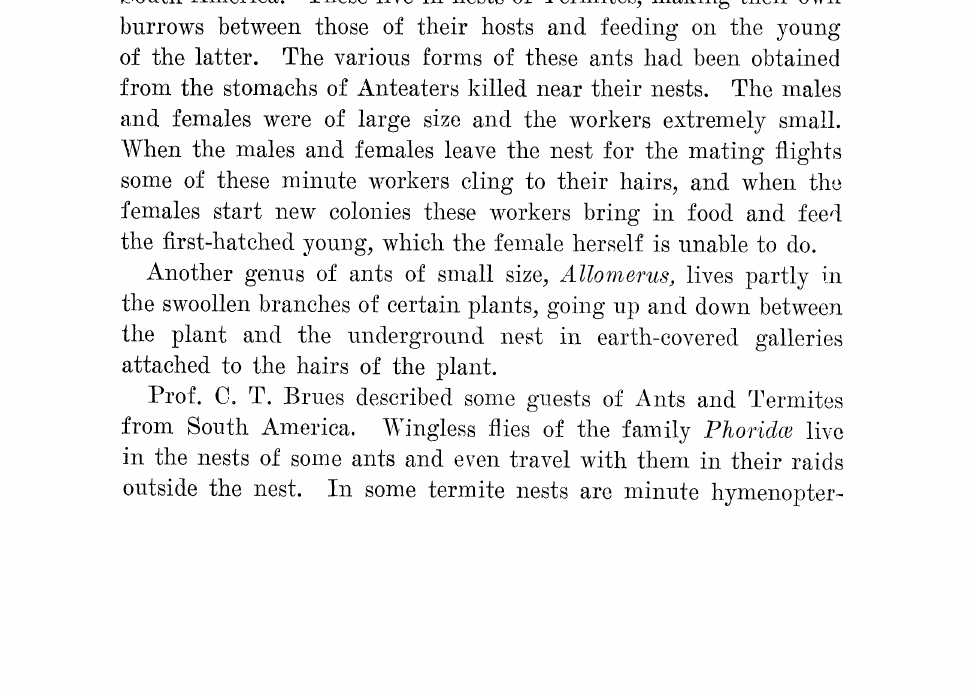
Fig. 5. Posterior (ventral) view o: the paragnaths of the crustacean Apseudes. Fig. 6. Posterior (ventral) view of a pa.ragnath and mxillula of the crus- tacean Squilla. Fig. 7. Anterior (dorsal) view of a paragnath and maxillula of the crus- tacean Apus, bent over backward to show attachment to the basal lamina. Fig. 8. Ventral (posterior) view of a paragnath and the lingua of the insect Machilis. Fig. 9. Same view o1 a paragna.th of Mchiis taken from drawing by Carpenter. Fig. 10. Anterior view of metastoma of the trilobite Triarthrus from drawing by Raymond.